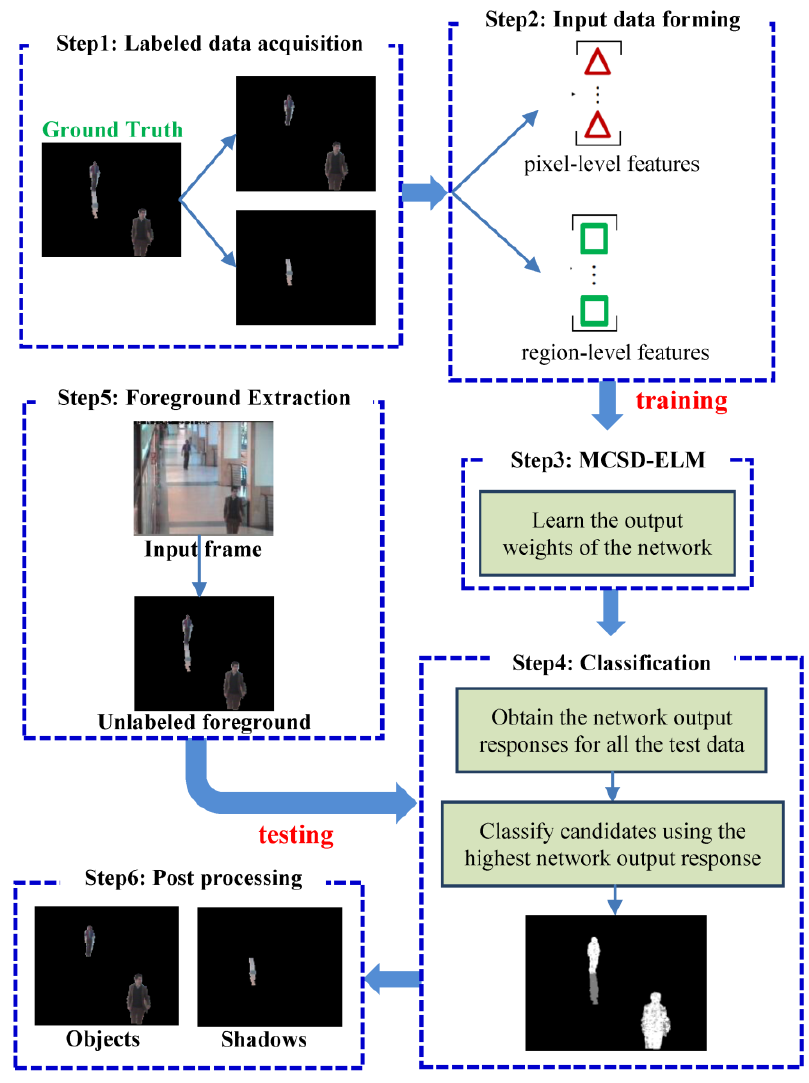
Figure 1. Overview of the proposed moving cast-shadow detection approach.